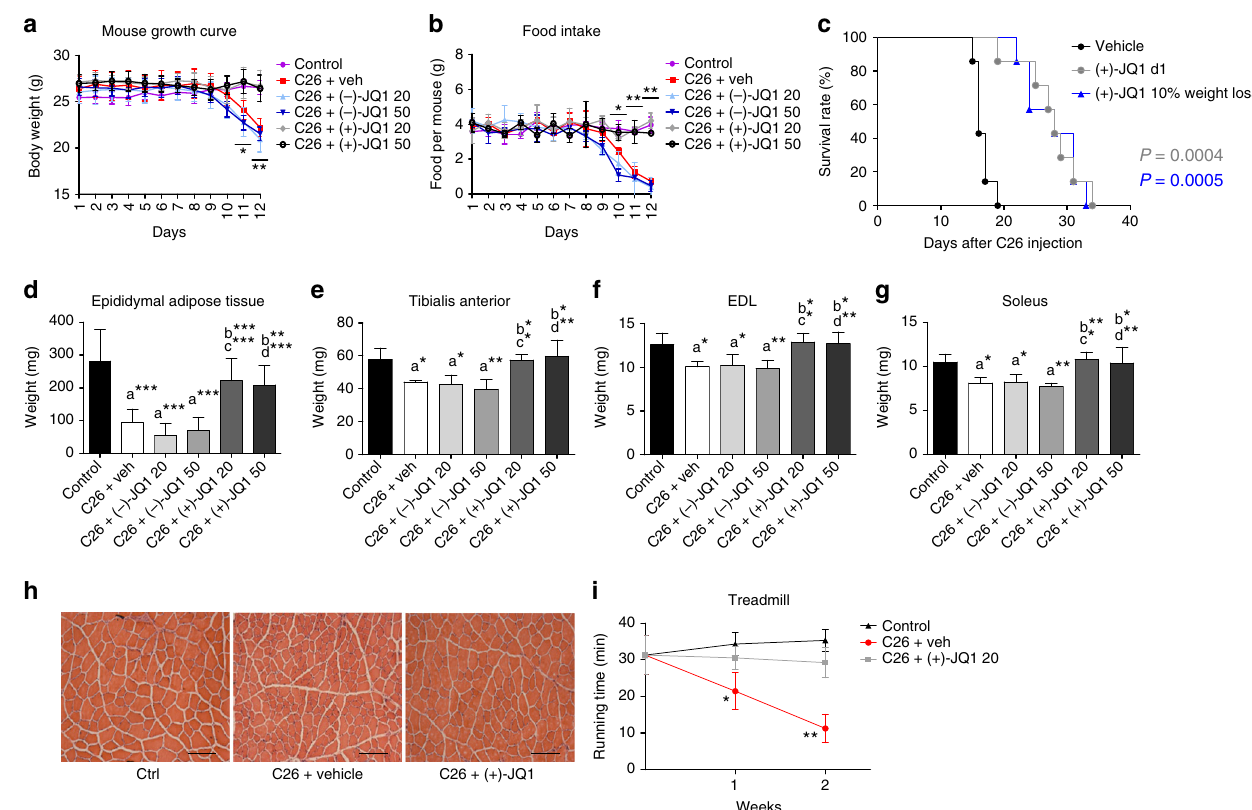
Fig. 2 JQ1 prolongs survival, and prevents muscle and white fat wasting. a Body weight chart of control, vehicle, ( − )-JQ1, and (+)-JQ1-treated C26-tumor- bearing mice. Day 0: tumor implantation. Day 1: JQ1 treatment started. Age-matched normal control mice were treated with vehicle (animals per group: n = 10). Data represent means ± SD. Statistical signi fi cance refers to (+)-JQ1-treated animals vs. vehicle and ( − )-JQ1-treated animals. b Chart displaying food intake in the six animal groups described in a . Data represent means ± SD. Statistical signi fi cance refers to (+)-JQ1-treated animals vs. vehicle and ( − )-JQ1- treated animals. c Survival rate of C26-tumor-bearing mice was measured in two animal groups: vehicle (veh) and (+)-JQ1 20mg/kg/day. Treatment was started either at day 1 (gray line) or when the average weight loss was 10% (blue line) (animals per group: n = 7). d Epididymal adipose tissue was weighted at day of sacri fi ce (day 12) in the six animal groups (animals per group: n = 10). Data represent means ± SD. e – g TA, EDL, and soleus were weighted 12 days after C26 cell implantation (animals per group: n = 10). Data represent means ± SD. h TA muscle morphology of Ctrl and C26-tumor-bearing mice